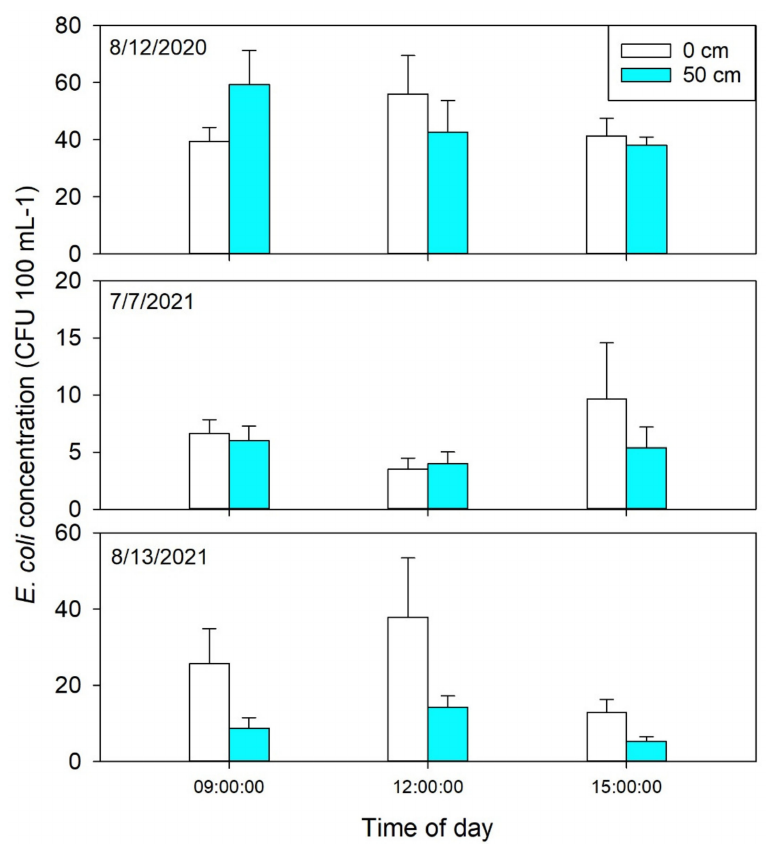
Figure 3. Concentrations of E. coli by sampling depth in Pond P3. Error bars show the standard error of the mean. Dates followed by the symbols ¤ and ‡ indicate statistical significance of the time of day and/or sampling depth, respectively, as a factor as determined by the two-way